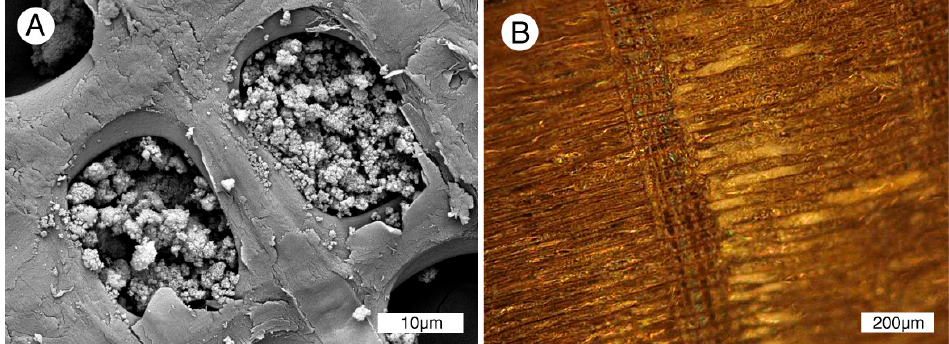
Figure 13. Experimental silica permineralization of modern conifer wood, Pseudotsuga menziesii . Samples were exposed to H 4 SiO 4 saturated solutions for ~90 days at 90 °C, with obsidian powder as the silica source [33]. ( A ) Transverse orientation, showing tracheid lumina filled with silica gel aggregate; ( B ) reflected light image of a longitudinal section cut parallel to the tracheids using a scalpel, showing lumina permineralized with silica gel. Photos courtesy of Chris Ballhaus, Bonn University.